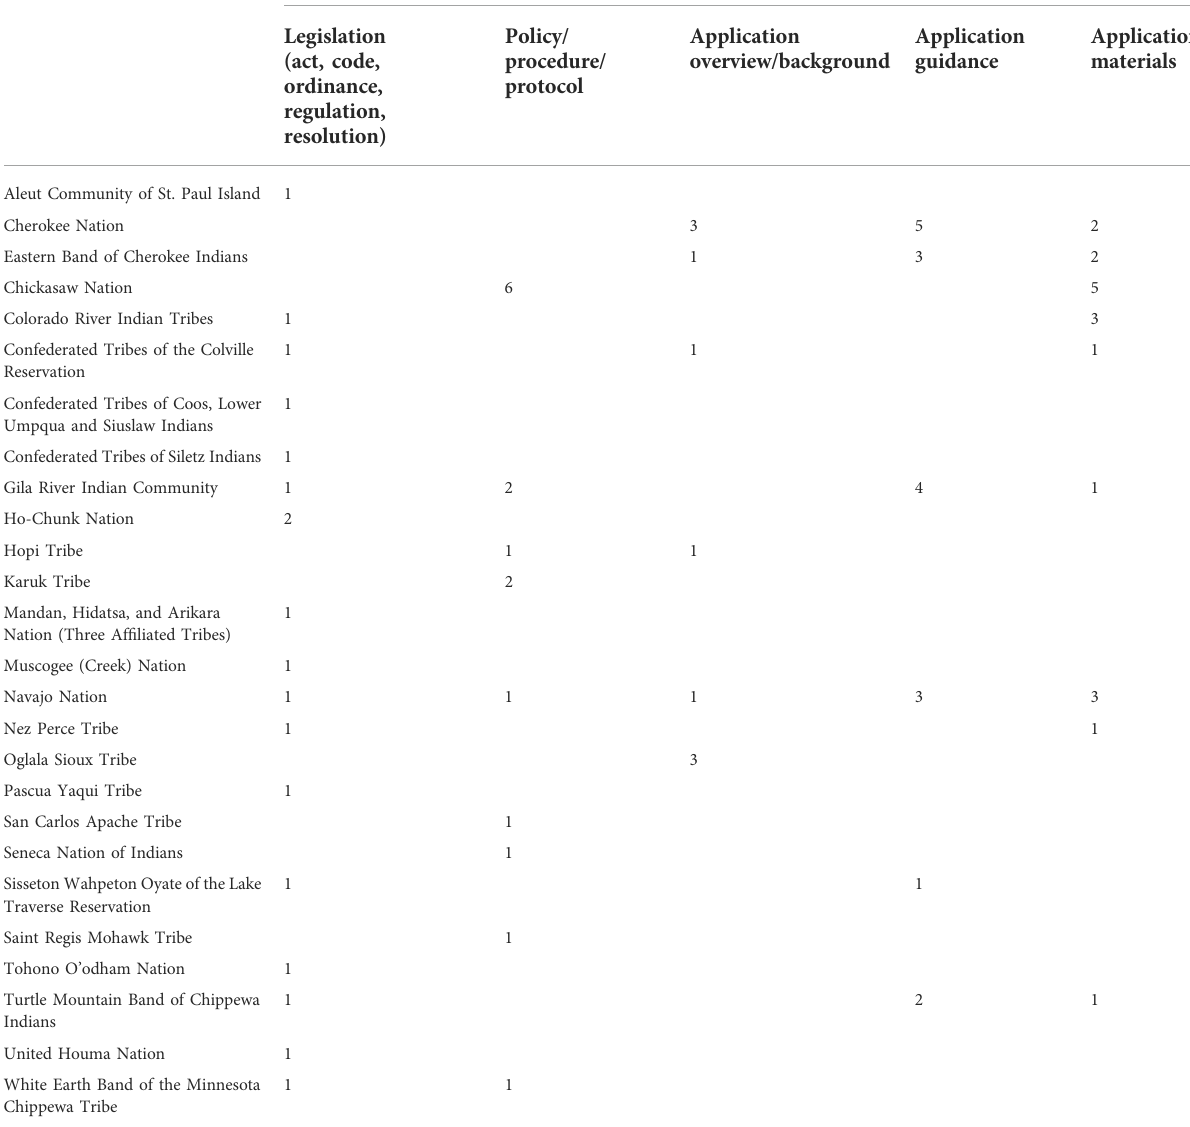
TABLE 1 Tribal research governance documents reviewed.